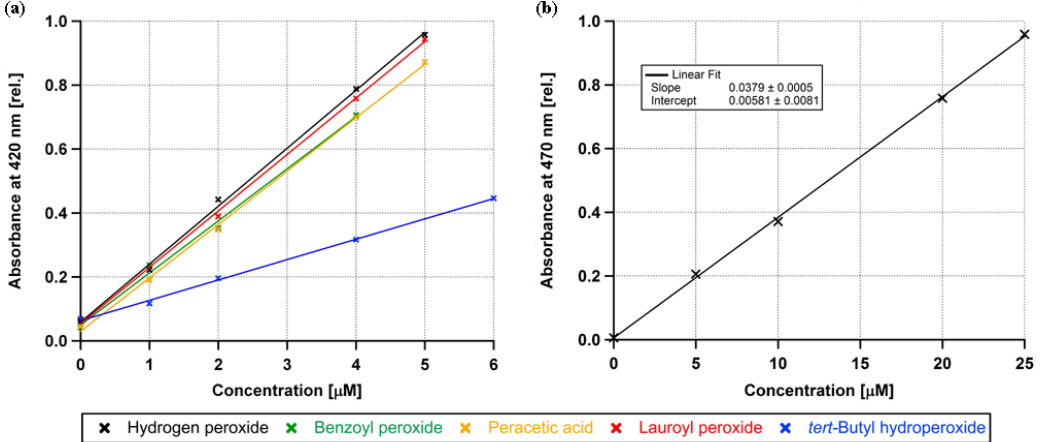
Fig. 3. (a) Calibration curves for absorbance data at 420nm. Linear fits are shown for 5 different peroxides in the concentration range of 0µM (i.e. KI only) up to 6µM. The slopes from these least squares linear regressions range between 0.064 ( tert -butyl hydroperoxide) and 0.181 (hydrogen peroxide). The slope of the less reactive tert -butyl hydroperoxide is about 2.5 times lower compared to those of the other peroxides. (b) Calibration curve of hydrogen peroxide from the absorbance at 470nm. Peroxide concentrations range from 0µM (i.e. KI only) up to 25µM. Least squares linear regression gives a R 2 of